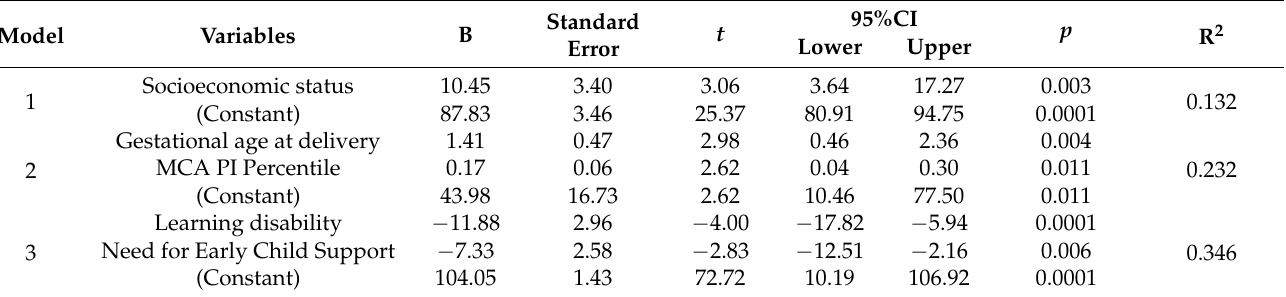
Table 9. Best fit linear regression models of different